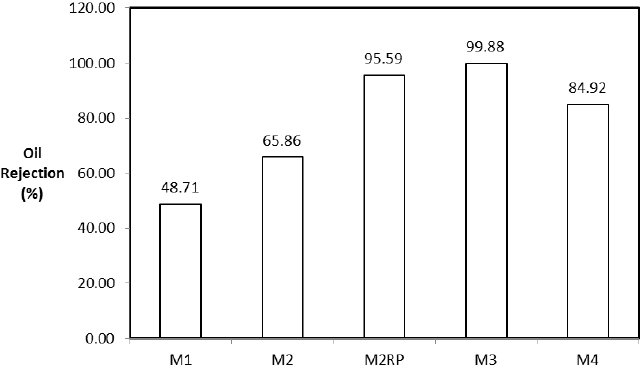
Figure 9. The oil rejection for the membranes. M2RP is the membrane prepared and reported